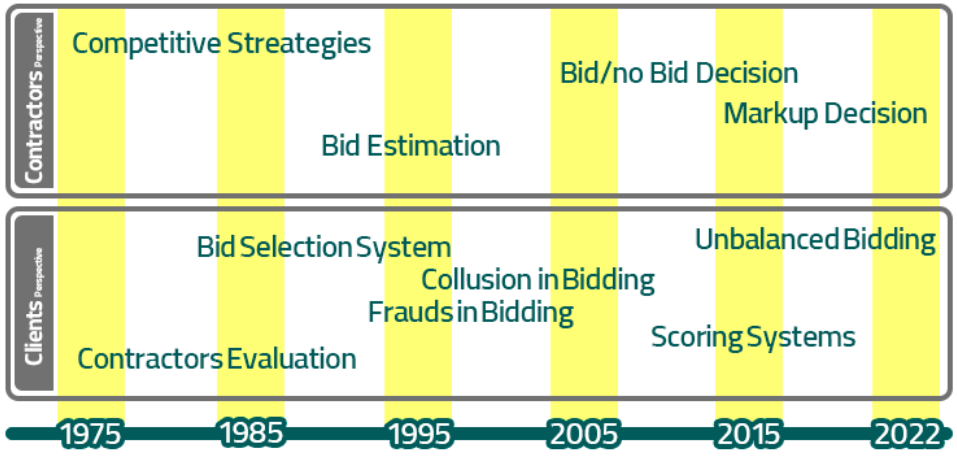
Figure 7. The chronological trend of the development of hot bidding topics during the past five decades (1975 to 2022).